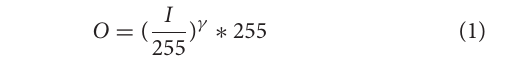
with “Blur,” “Dark,” “Far,” “Contains Reflections,” and “Cropped” quality